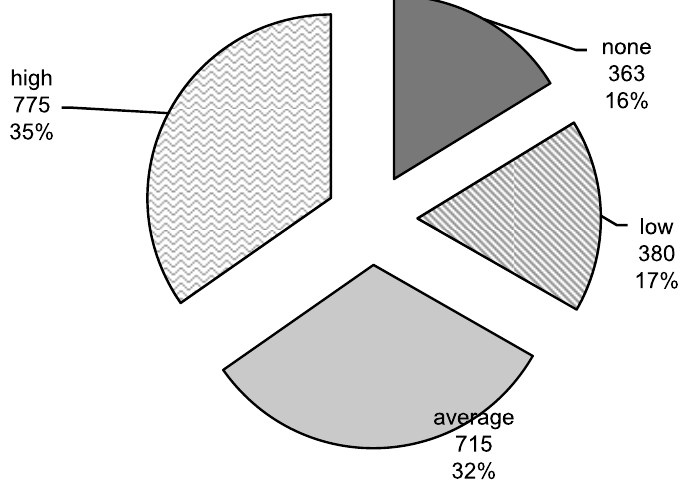
Figure 1. Students’ access to ICTs off